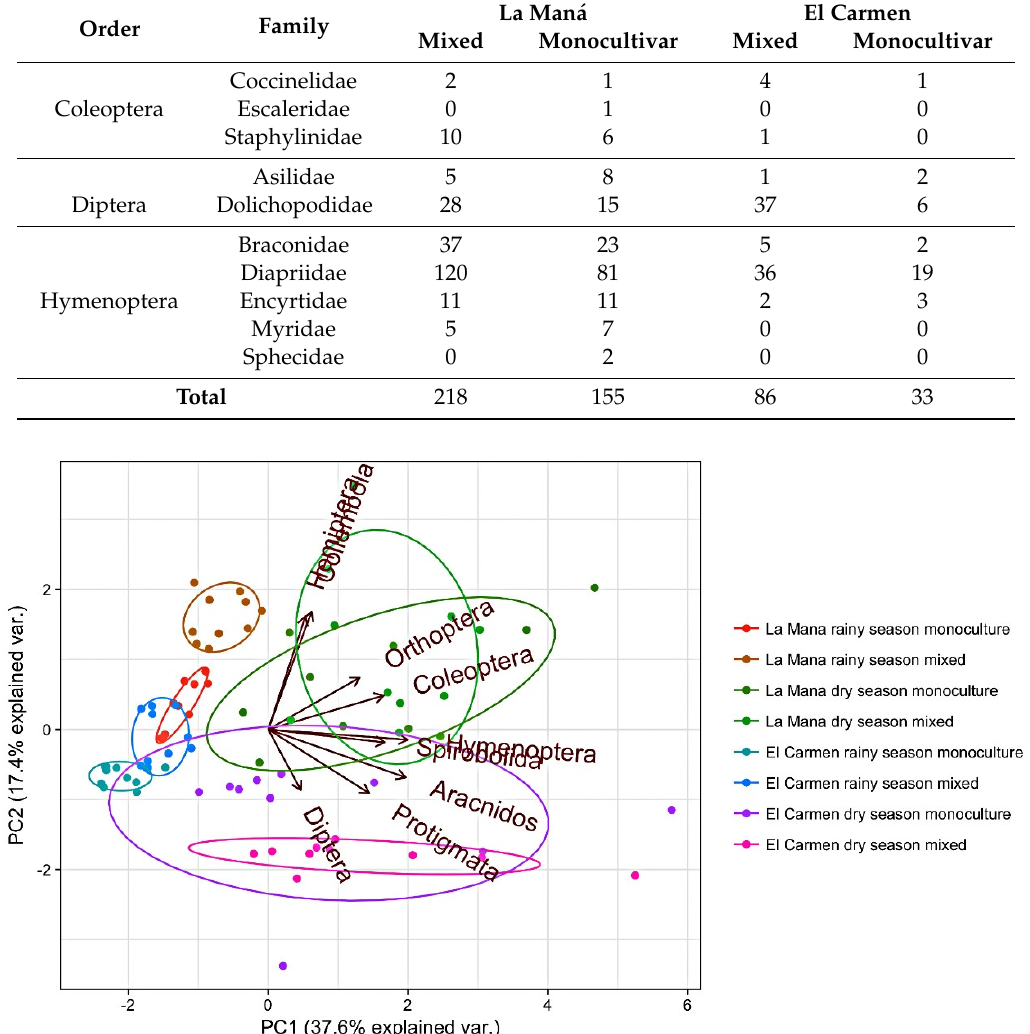
Figure 2. Principal component analysis (biplot) between sites, season, agricultural systems and number of arthropod orders